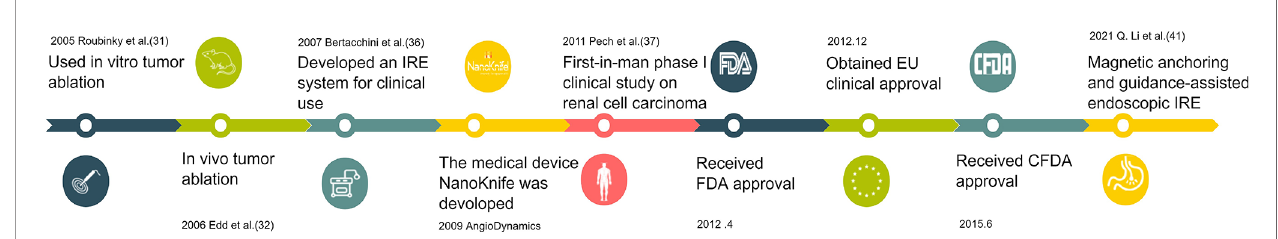
FIGURE 1 | A timeline for the development of irreversible electroporation (IRE) on